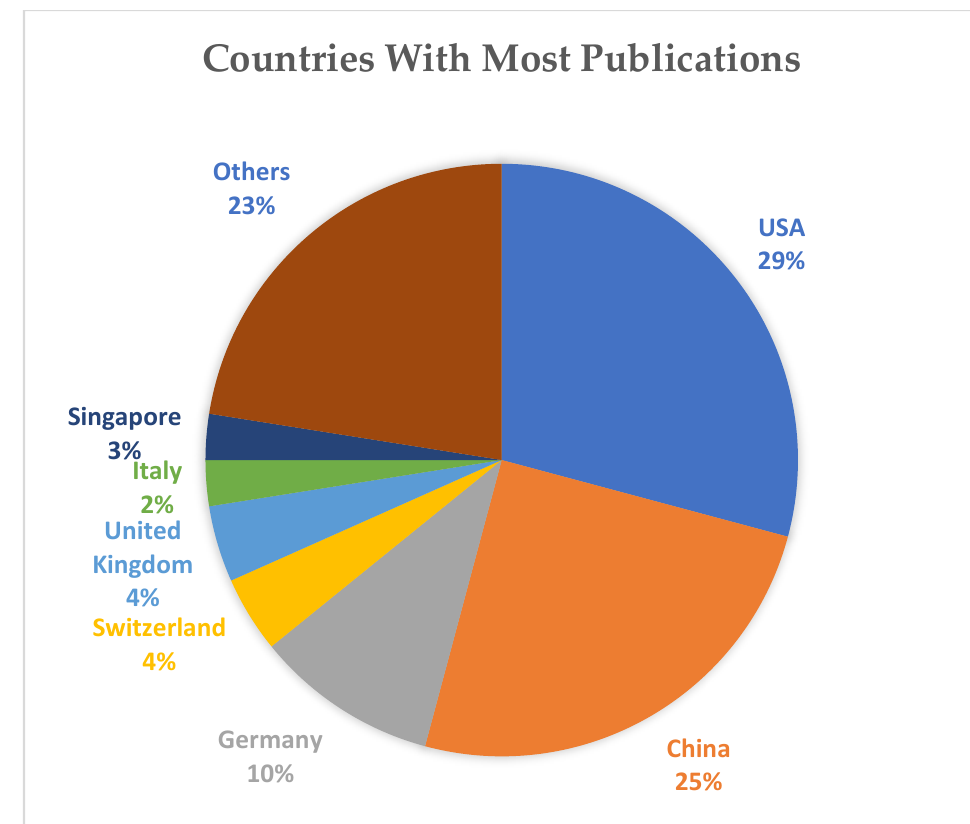
Figure 5. Countries with the most publications.